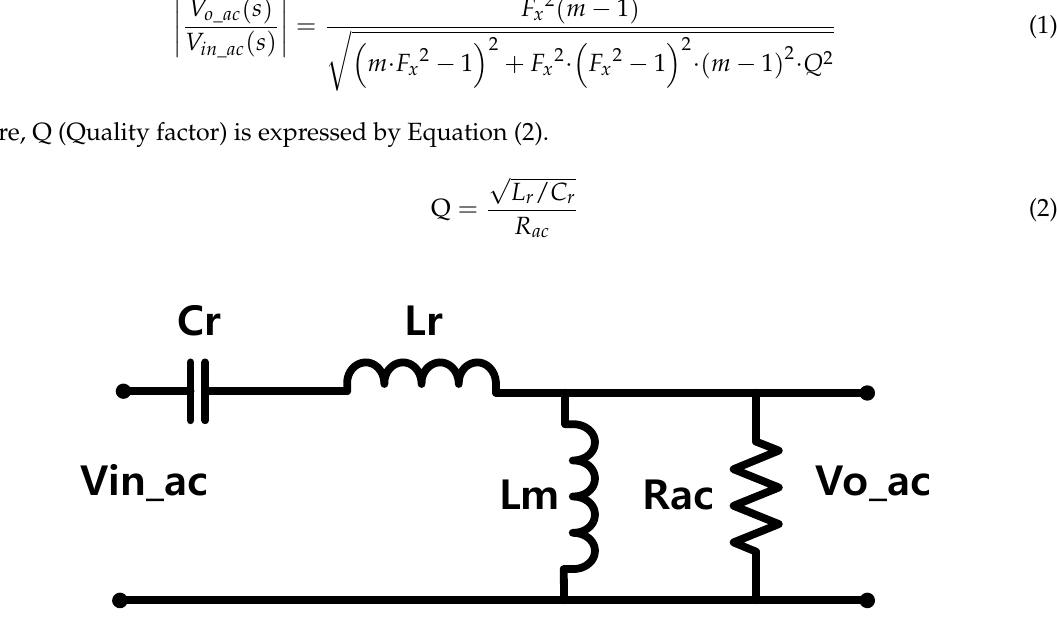
Figure 2. The equivalent resonant circuit.